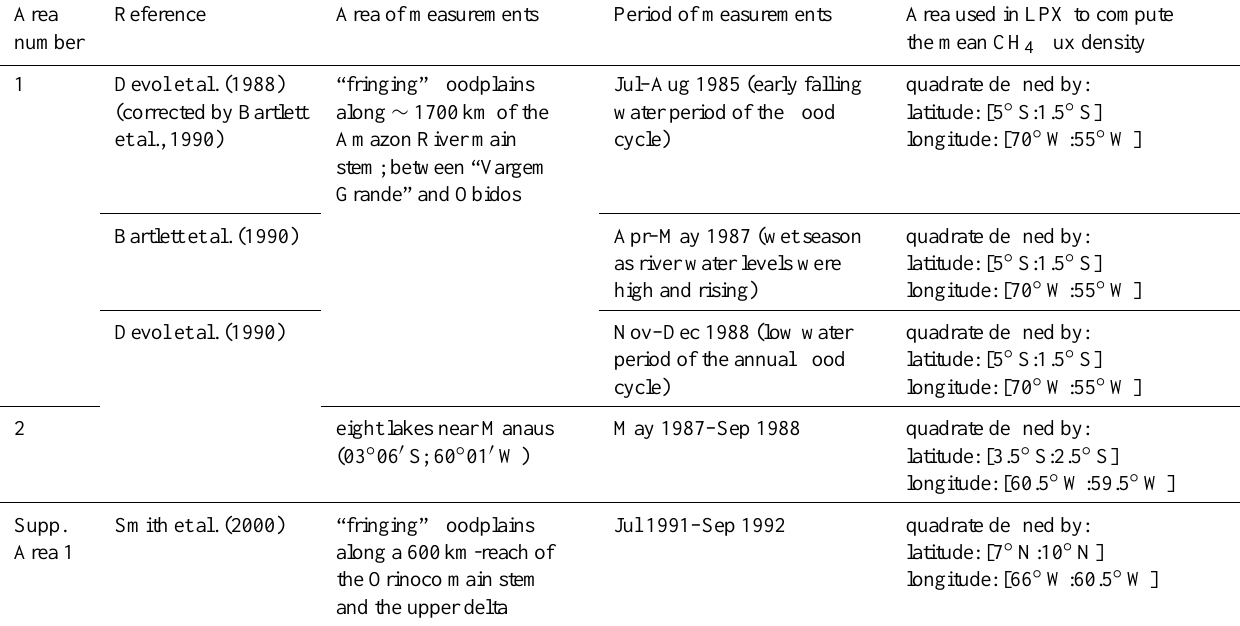
Table 6. Available information about CH 4 flux density at large scale. Geographical areas selected to estimate comparable LPX-computed CH 4 flux densities are given in the last column. Areas 1 and 2 are in the Amazon Basin, while the last area (Supp. Site 1) is located in the Orinoco Basin. Despite some differences in the spots used to estimate the mean CH 4 flux density, we consider that Devol et al. (1988), Bartlett et al. (1990) and Devol et al. (1990) give information about the same geographical